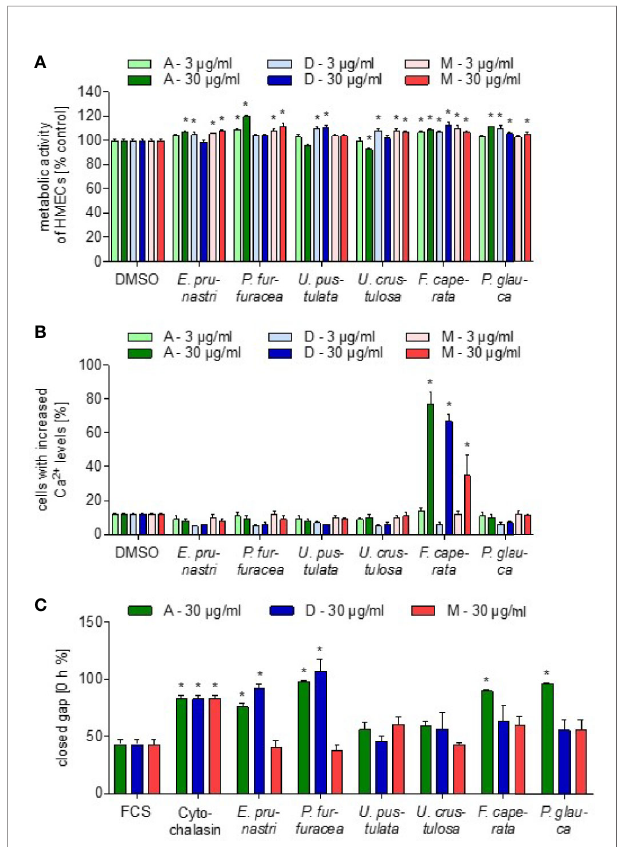
FIGURE 1 | Effects of lichen extracts on general cell functions. (A) For the cell viability assay, HMEC-1 cells were grown to con fl uence and treated with lichen extracts (3 and 30 µg/ml) or dimethyl sulfoxide (DMSO) (control) for 24 h. Resazurin-containing CellTiter-Blue reagent was added for the last 4 h of treatment. The metabolic activity was quanti fi ed by fl uorescence measurements of resoru fi n. Data are expressed as mean ± SEM. n=2, *p ≤ 0.05 versus control. (B) For the Ca 2+ -assay, HEK293 cells were preincubated with Fluo-8-AM. Lichen extracts (3 and 30 µg/ml) or DMSO (control) were added for 5 min. Data are expressed as mean ± SEM. n=3, *p ≤ 0.05 versus control. (C) For the scratch assay, the NIH3T3 monolayer was scraped in a straight line and thereafter treated with 30 µg/ml of lichen extracts or with 650 nM cytochalasin (positive control) or DMSO (control) for 24 h. The size of the gap after 12.5 h was related to the size of the gap at 0 h and shown as % value. Data are expressed as mean ± SEM. n=2, *p ≤ 0.05 versus